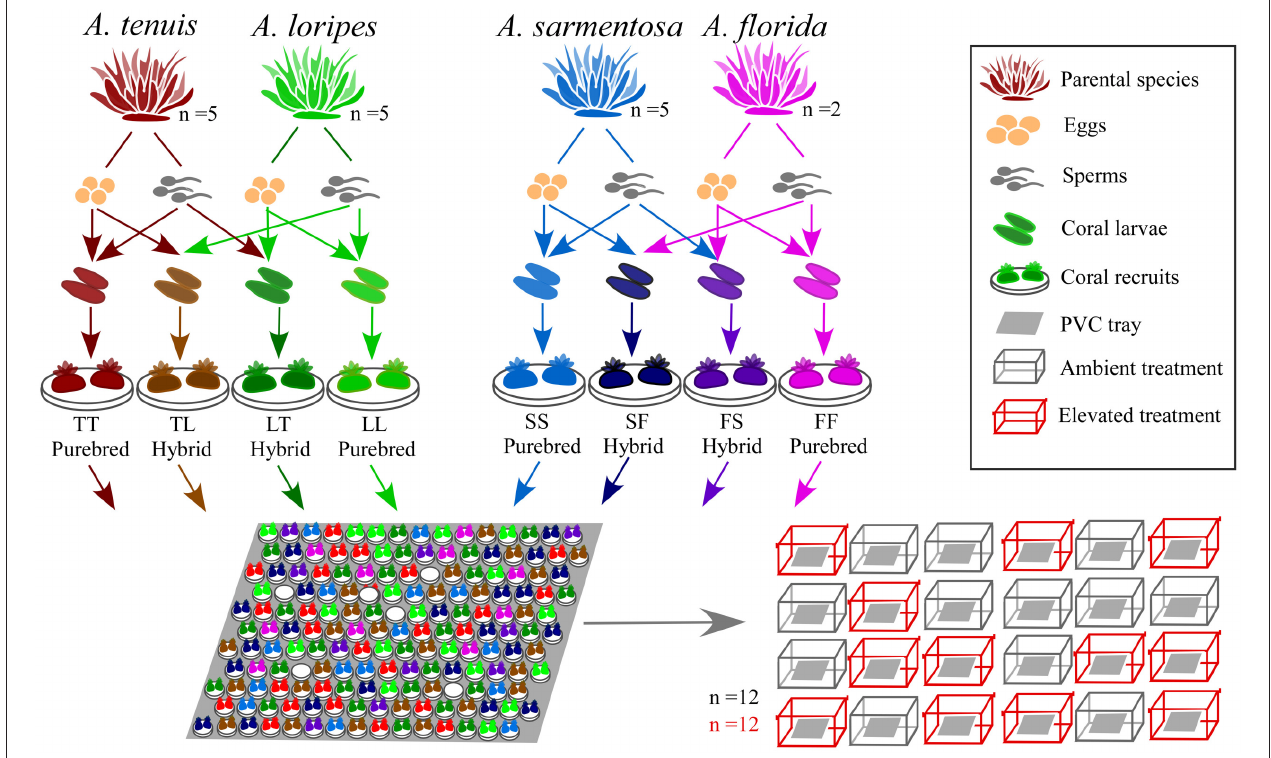
FIGURE 2 | Experimental set up showing the two interspecific crosses [i.e., A. tenuis (T) × A. loripes (L) and A. sarmentosa (S) × A. florida (F)], the four resultant offspring groups from each cross (TT, TL, LT, LL; and SS, SF, FS, FF, respectively), larval settlement, and comparison of hybrid and purebred fitness under ambient and elevated conditions. The abbreviation of the offspring groups throughout this paper is that the first letter represents the origin of the eggs and the second letter the origin of sperm [e.g., SF is a hybrid of A. sarmentosa (S) eggs with A. florida (F) sperm]. The different colors used for the offspring groups in the figure reflect differently colored settlement plugs used for each offspring